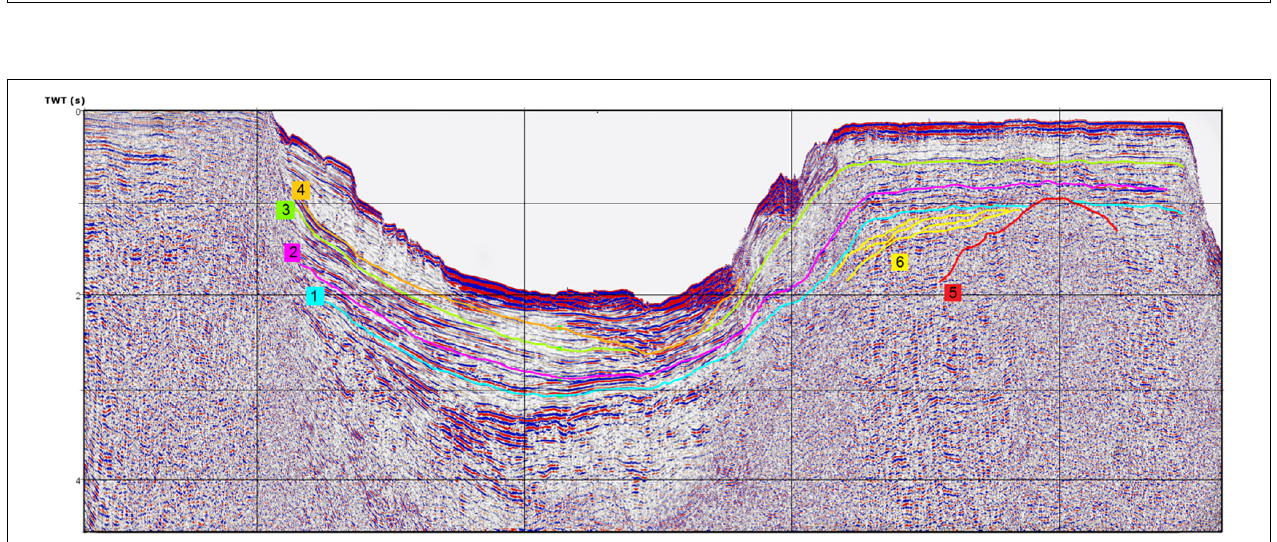
FIGURE 2 | SW-NE interpreted seismic profile from ANP survey, line POT44 (Jovane et al., 2016) (location on Figures 1 , 3 ). Depth in seconds, TWT (Two-Way travel Time). Horizon 5 is the interpreted volcanic basement of the CP, the other horizons are sedimentary deposits related to geologic ages (from Jovane et al., 2016).